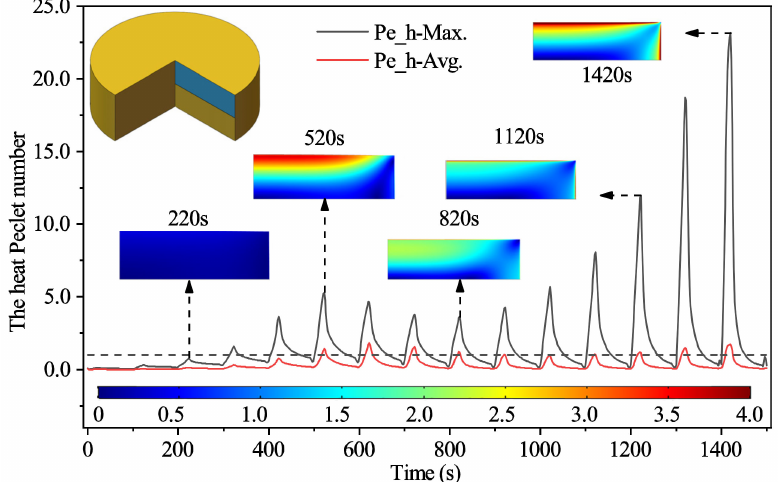
Figure 10. The maximum and average heat Pe numbers at different